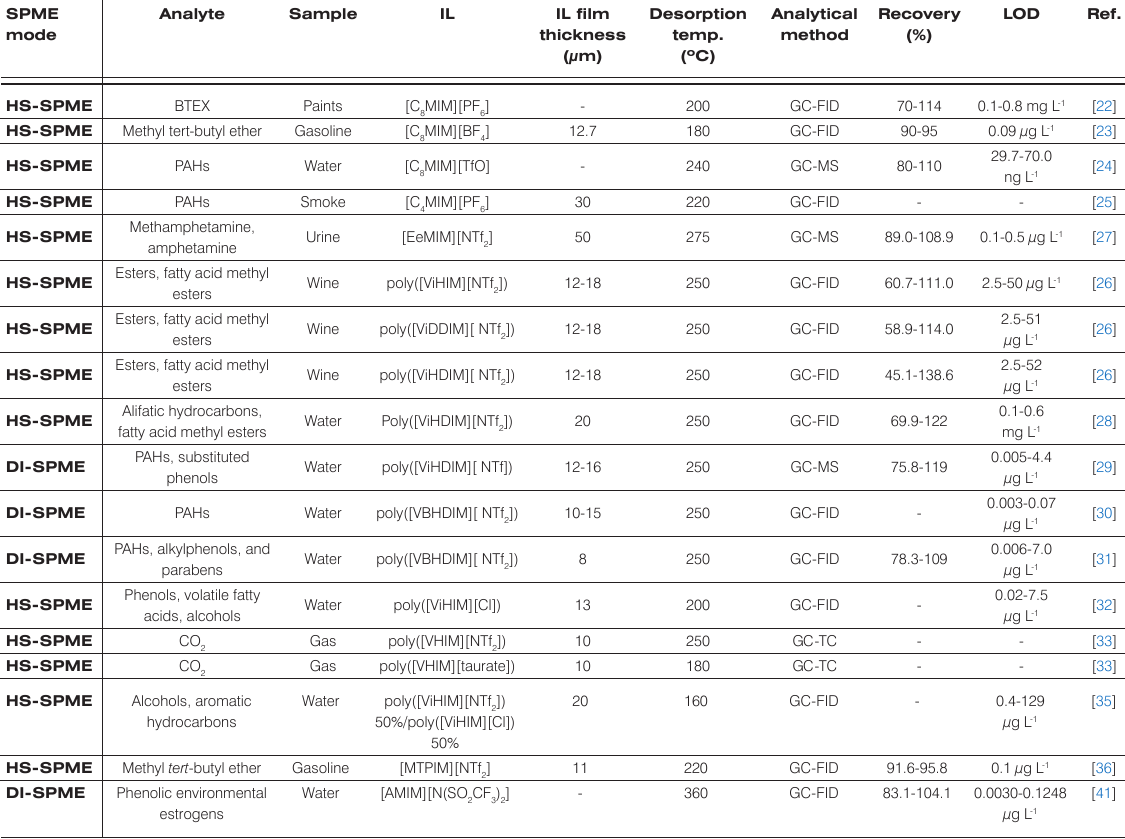
Table 2. Representative examples on the use of ILs in